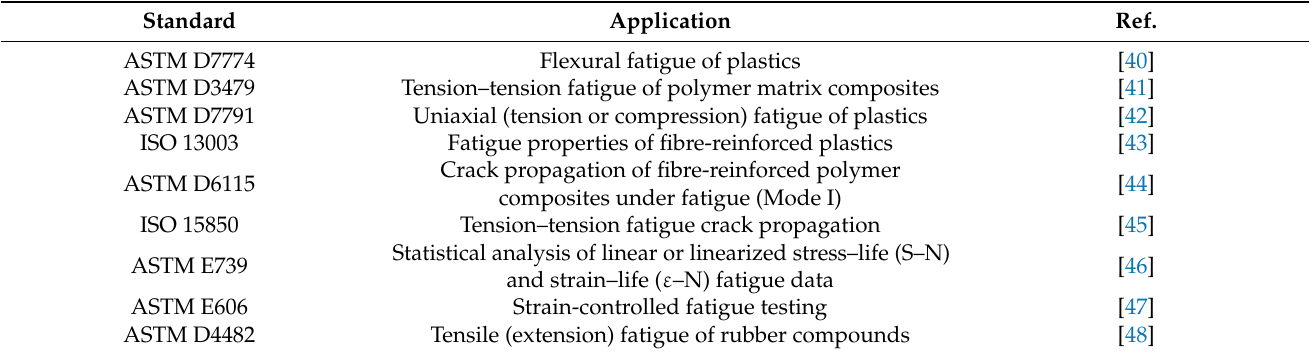
Table 1. Existing standards for the fatigue testing of